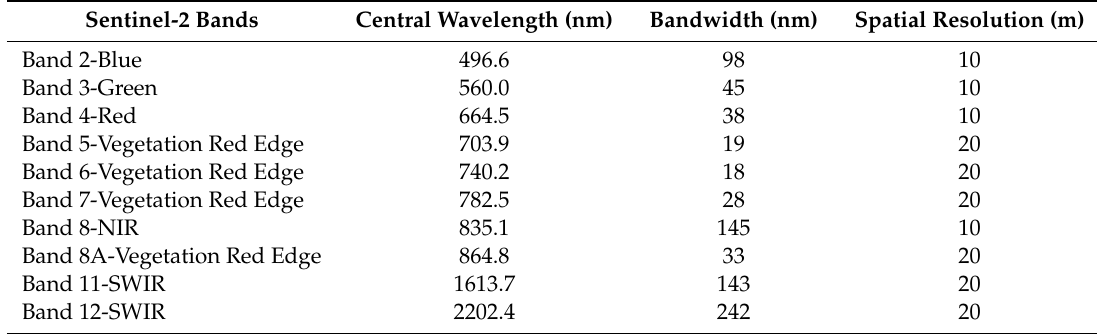
Table 3. Bands of the Sentinel-2 images used in the study.